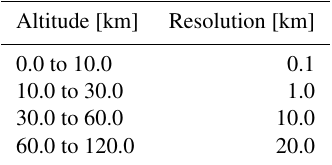
Table 1. Vertical resolution of the radiative transfer